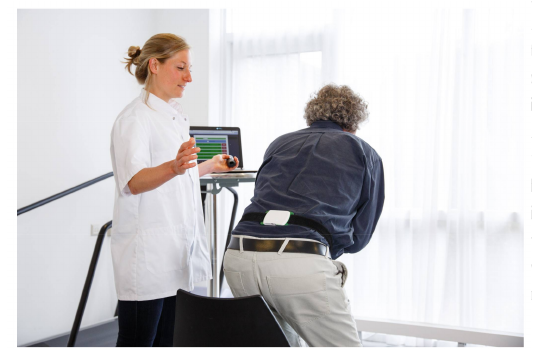
Figure 1. The experimenter stayed in close proximity to the patient. The protocol was implemented on a computer. With a remote control, the start and end of every STS was marked and stored with the raw data.